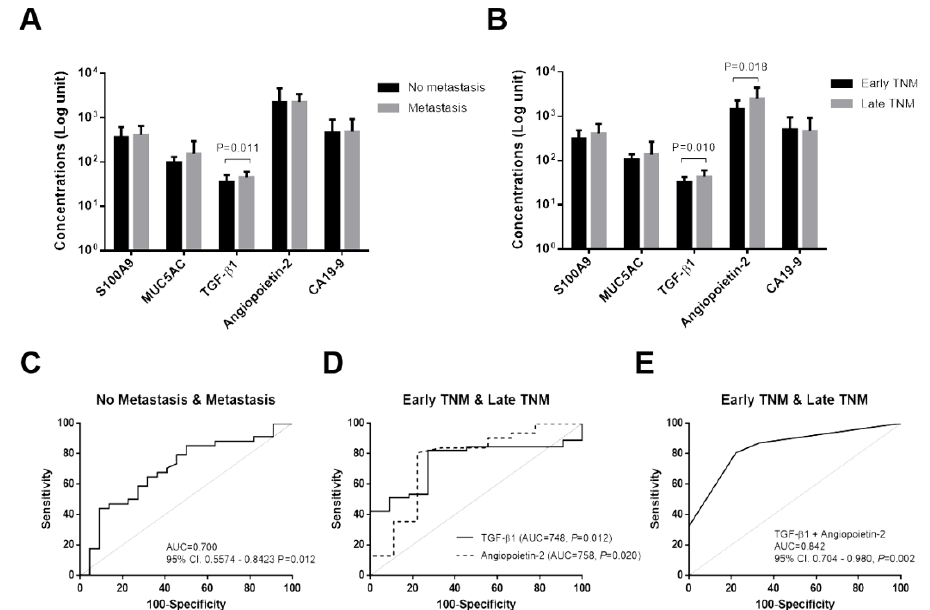
Figure 5. Serum levels of candidate prognostic-biomarkers in CCA patients according to metastasis ( A ) and TNM stages ( B ). Column bar graph represents mean ± standard deviation (SD). Receiver operating characteristic curve (ROC) analysis of candidate biomarkers for prognosis in CCA, TGF- β 1 for prediction of metastasis ( C ), TGF- β 1 and angiopoietin-2 for prediction of TNM stages ( D ), combined TGF- β 1 and angiopoietin-2 for prediction of TNM stages ( E ). The p value < 0.05 was considered statistically significant.